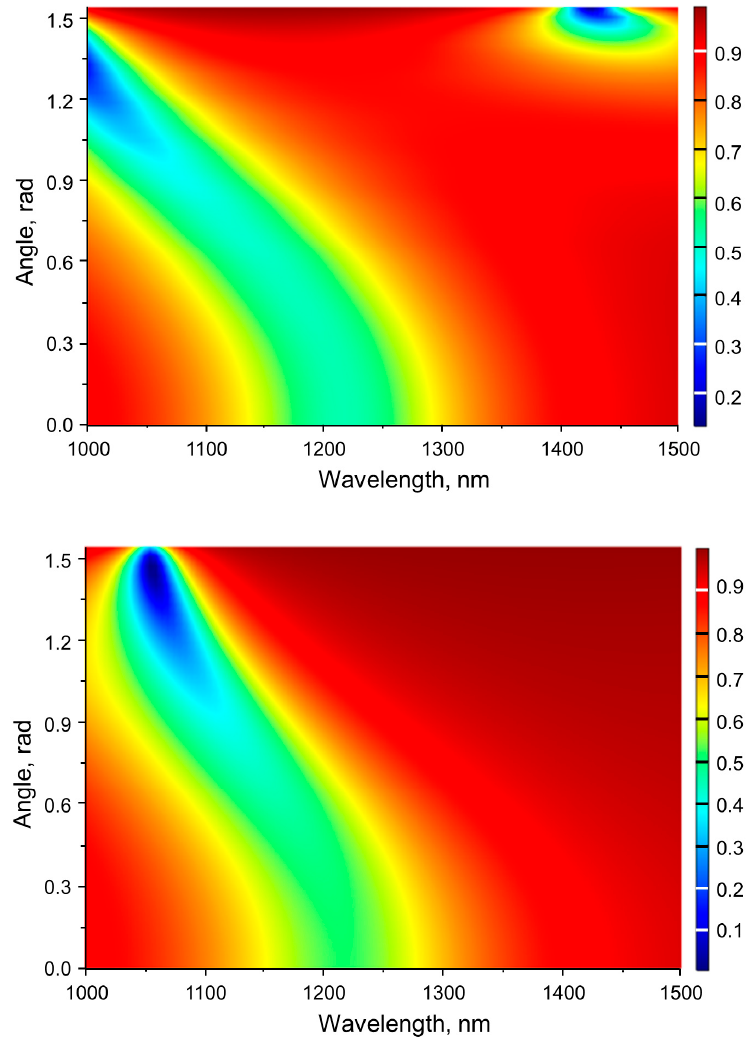
Figure 7. Full spectral dispersion of reflectance for TM ( top image ) and TE ( bottom image ) polariza- tions for the simple structure shown in Figure 1a when illuminated from the